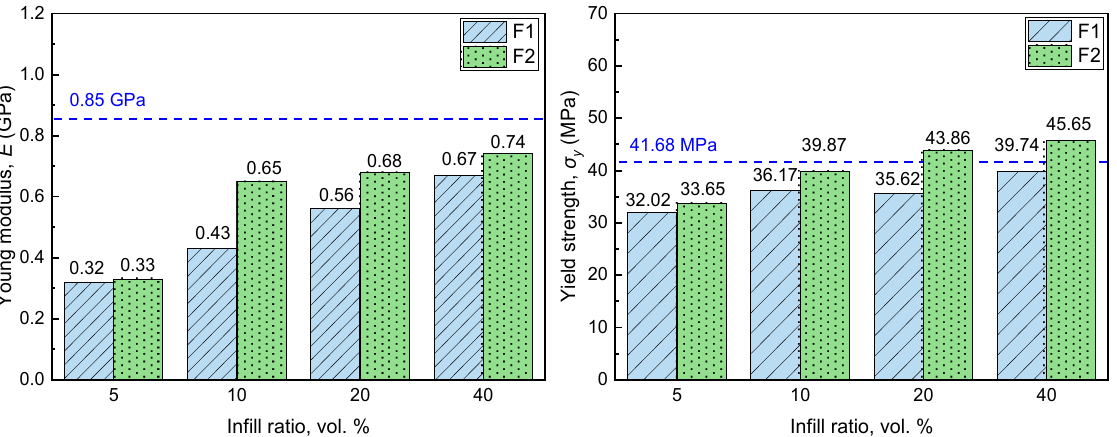
Figure 6. Young’s modulus and yield strength of samples prepared using different proportions of F1 and F2 fillers. Horizontal dashed blue lines denote respective property value for sample prepared solely with ABS.